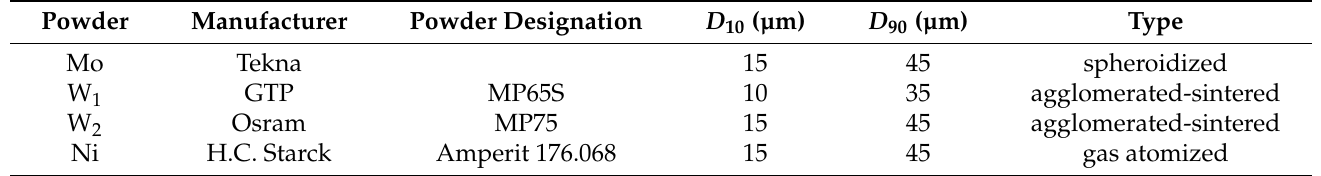
Table 1. Used feedstock powder information. The D 10 and D 90 represent particle size volumetric quantiles.